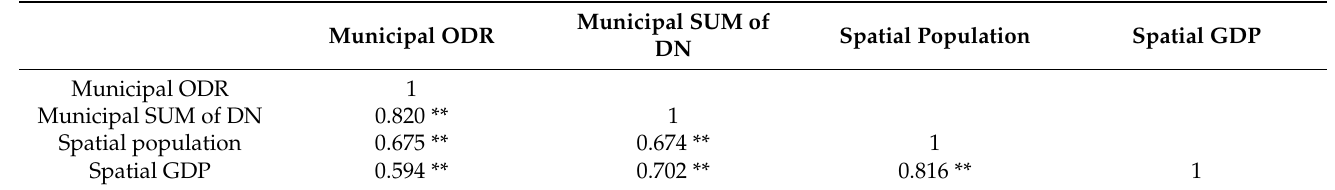
Table 6. Correlations between the municipal ODR and nighttime light SUM of DN, spatial population, and spatial GDP.